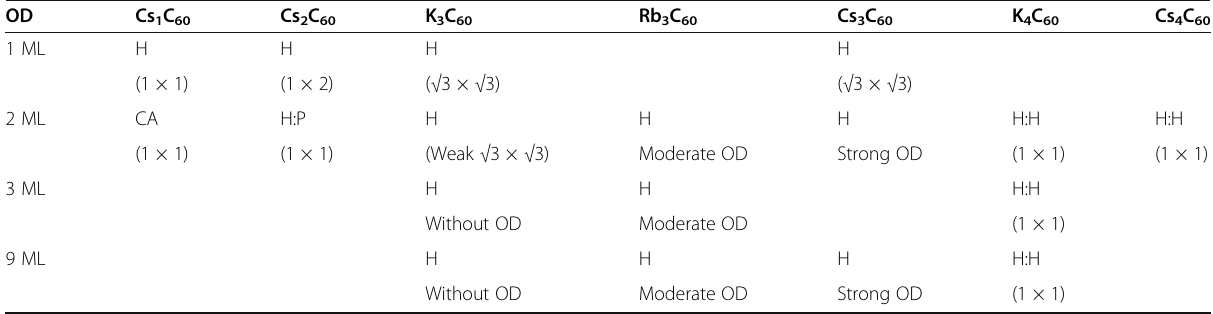
Table 1 A brief summary of C 60 orientations and their orderings in A x C 60 films prepared on graphene. H, CA, H:P, H:H donate the C 60 orientations. OD is short for merohedral disorder. Taken from ref. [44 –